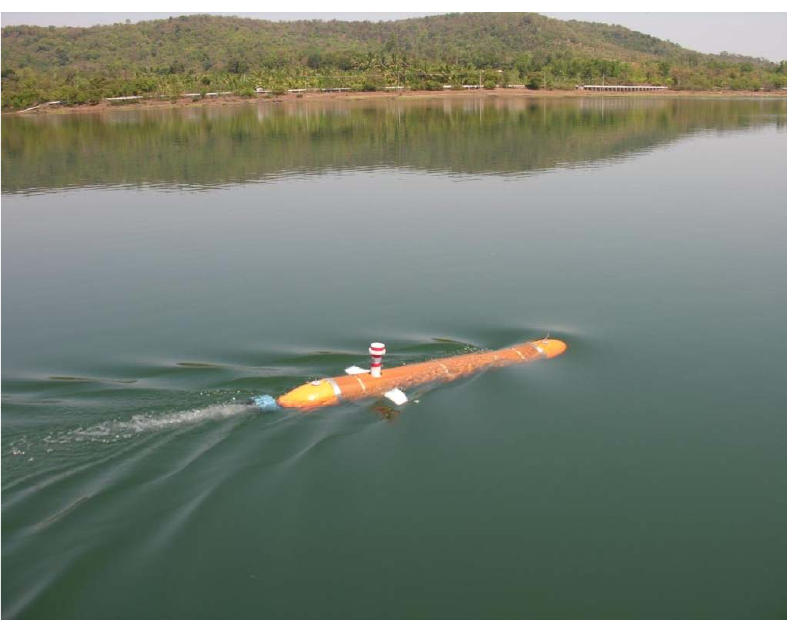
Figure 15. The MAYA